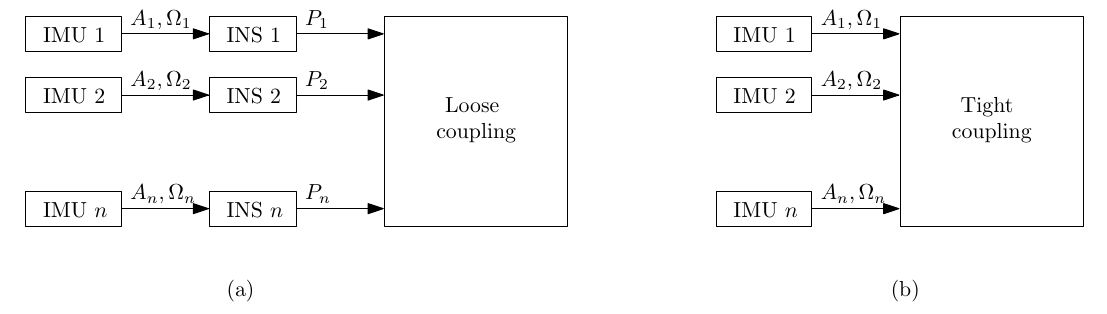
Figure 1. Block diagram of the ( a ) loose coupling approach and ( b ) tight coupling approach. A i , Ω i and P i represent the acceleration vector, turn rate vector and position vector respectively.